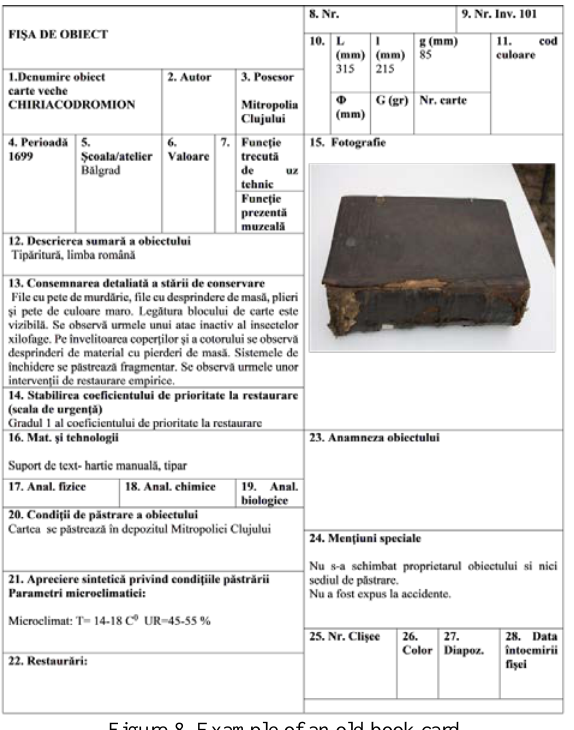
Figure 8. Example of an old book card Geospatial products obtained by processing satellite imagery provide